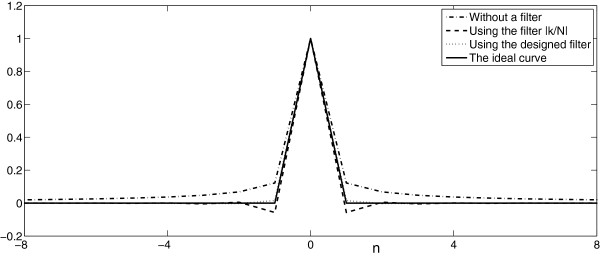
The comparison of the 0-th rows of reconstruction matrixes with and without the reconstruction filters (N=256,θ=[0o,3o,⋯,177o]).